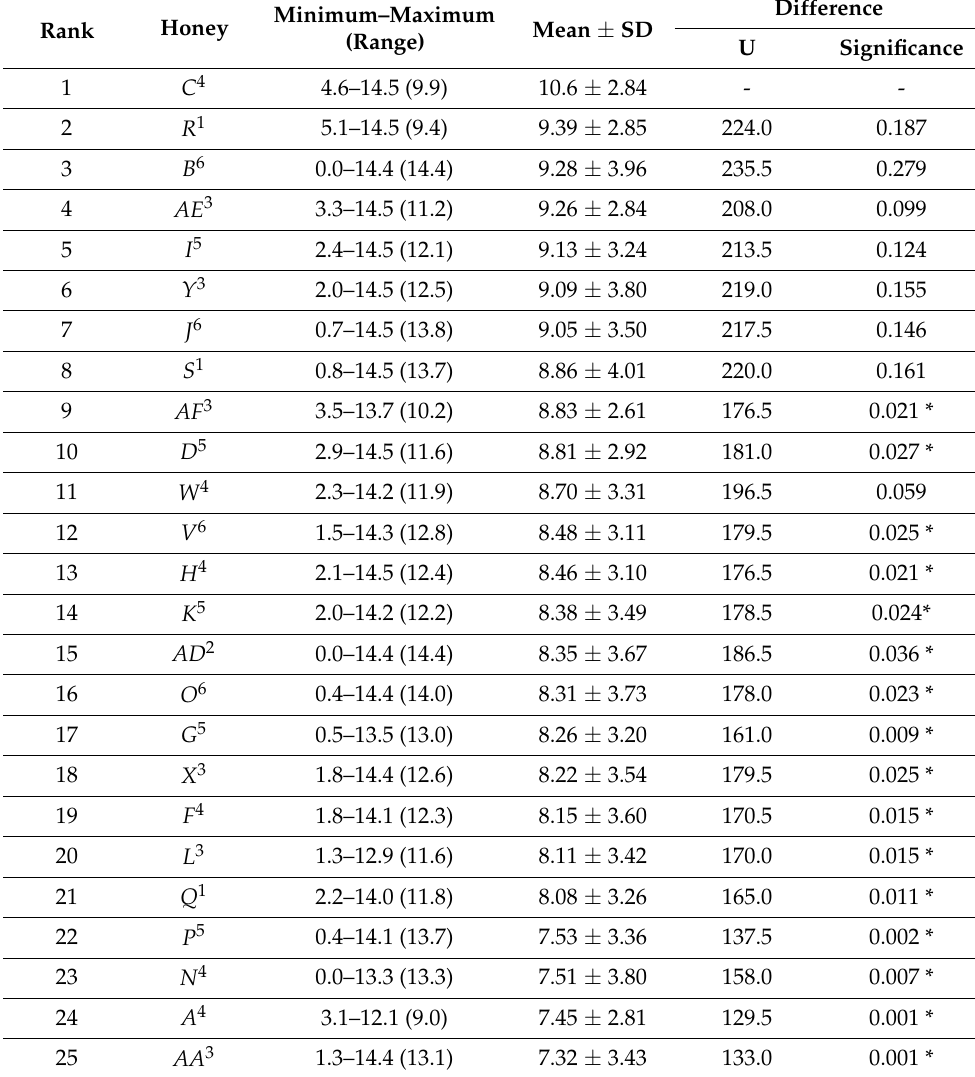
Table 1. The perceived consumer likeability of a range of commercially available Australian honeys. Rank